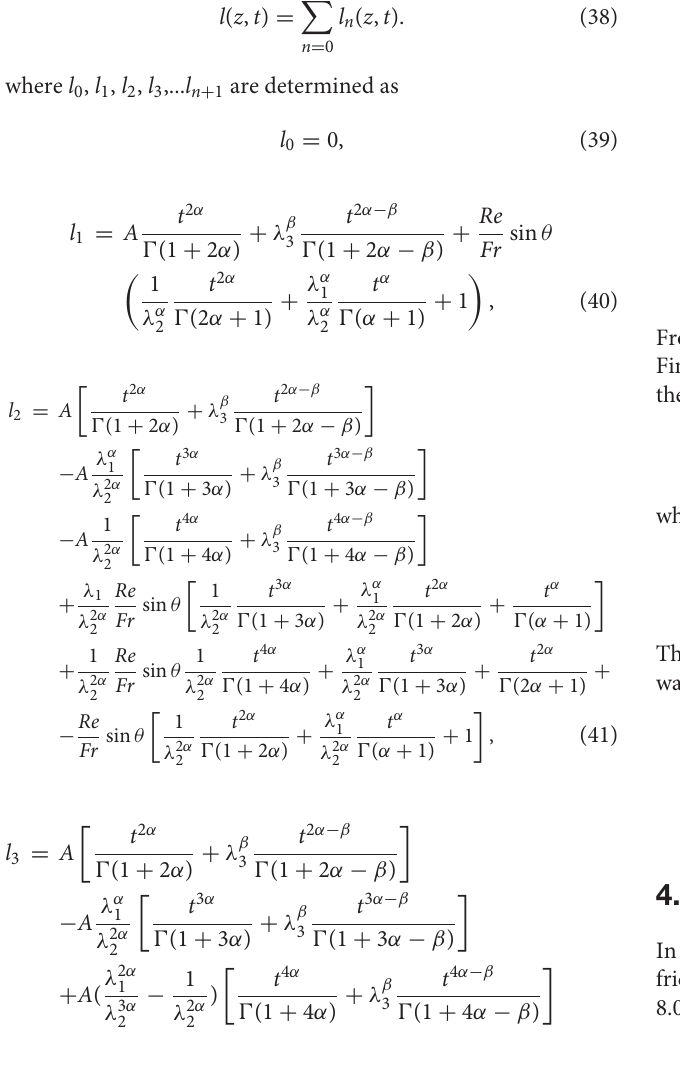
TABLE 1 | Pressure rise, pressure gradient, and frictional force for the four rheological models considered here. Fluid